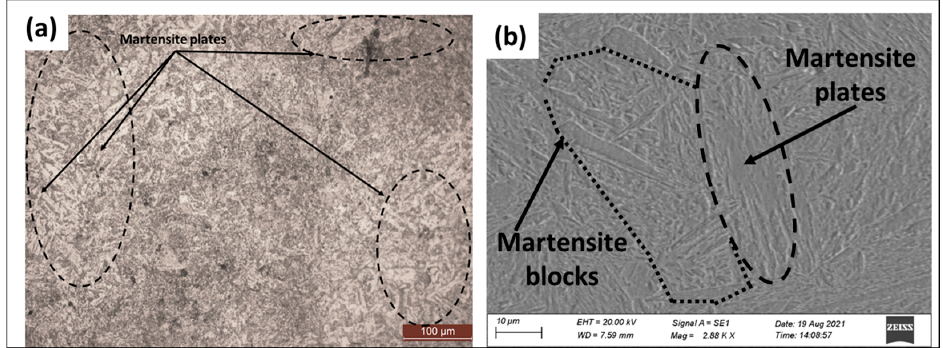
Figure 3. Microstructure of base material (EN25 Steel) ( a ) optical micrograph, ( b ) scanning electron micrograph .